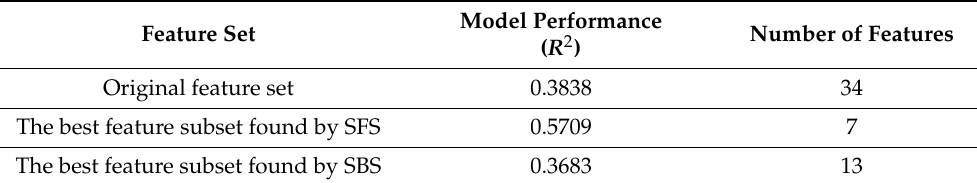
Table 6. Results of feature selection using KNN.